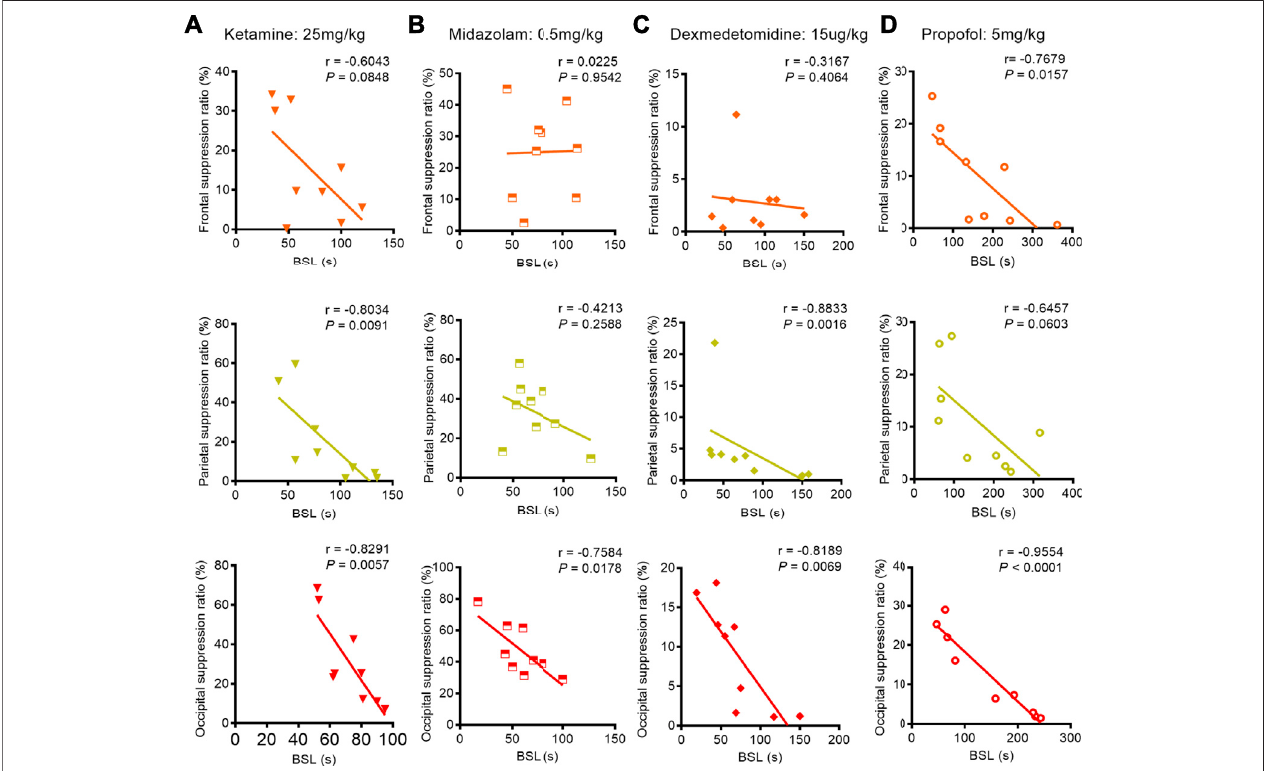
FIGURE 6 | Correlation between BLS and BSR during the co-administration anesthetics or adjuvant drugs with 1.0% iso fl urane anesthesia. (A) During the co- administration ofketamine with1.0%iso fl urane anesthesia,wefoundaweaknegativecorrelation betweenBSL and BSRinthefrontal lobe( n (cid:1) 9), while theparietal and occipital recordings revealed strong negative correlations between BSL and BSR ( n (cid:1) 9, respectively). (B) During the co-administration of midazolam with 1.0% iso fl urane anesthesia, no correlation between BSL and BSR was found from frontal or parietal recordings ( n (cid:1) 9, respectively); however, the occipital lobe EEG recordingindicatedstrongnegativecorrelationbetweenBSLandBSR( n (cid:1) 9). (C) Duringtheco-administrationofdexmedetomidinewith1.0%iso fl uraneanesthesia,no correlation was found between BSL and BSR in the frontal lobe ( n (cid:1) 9), while parietal and occipital recordings revealed strong negative correlations between BSL and BSR ( n (cid:1) 9, respectively). (D) After administering propofol as premedication during 1.0% iso fl urane anesthesia, the frontal and occipital EEG recordings showed strong correlations between BSL and BSR ( n (cid:1) 9, respectively); however, only a weak negative correlation between BSL and BSR was found from parietal recordings ( n (cid:1)